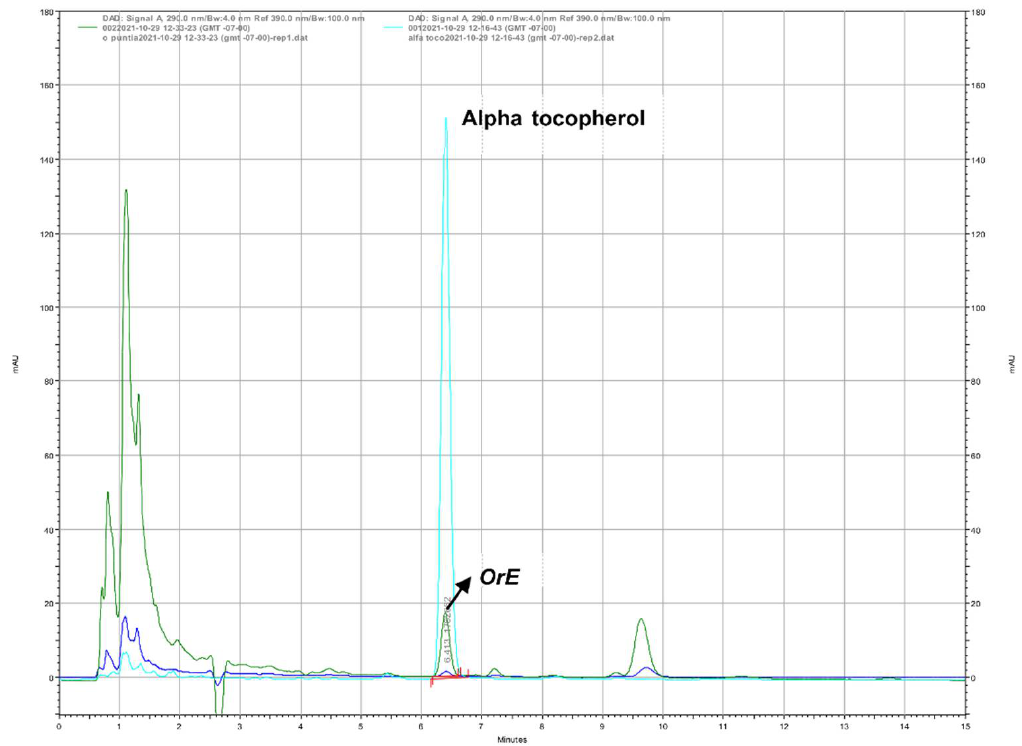
Figure 2. HPLC-UV chromatogram of alpha tocopherol standard and vitamin E in Opuntia robusta extract ( OrE ).